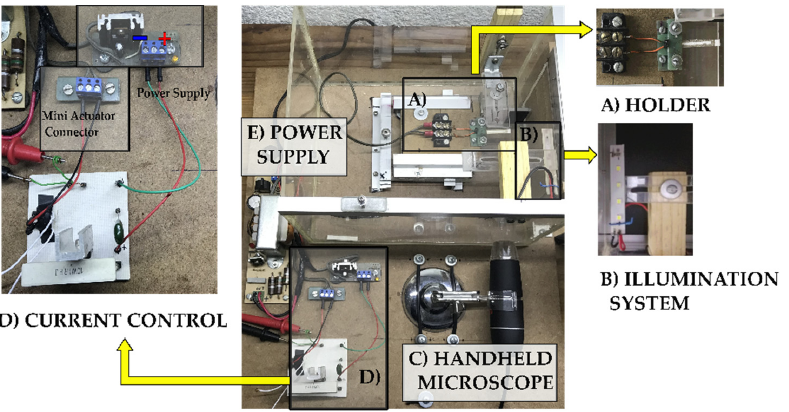
Figure 5. Experimental setup used for testing and to validate the proposed mini actuator com-